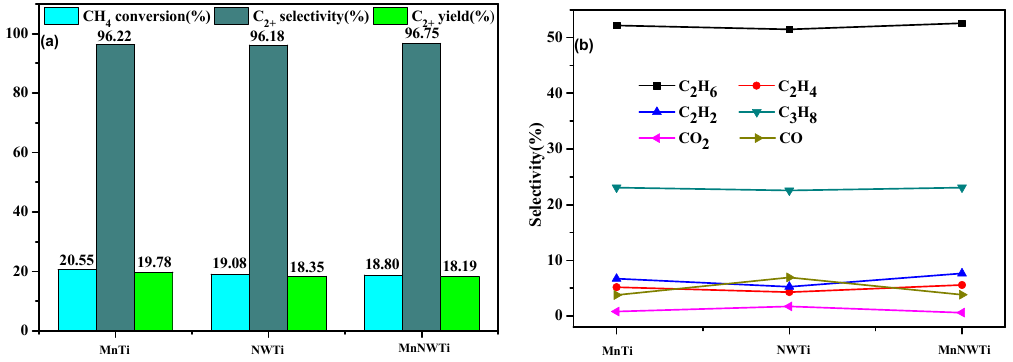
Figure 3. Performance of different metal loadings in DBD plasma. ( a ) Oxidative coupling perfor- mance; ( b ) product distribution (temperature: ambient temperature, flow rate: 60 mL/min, applied voltage: 100 V).